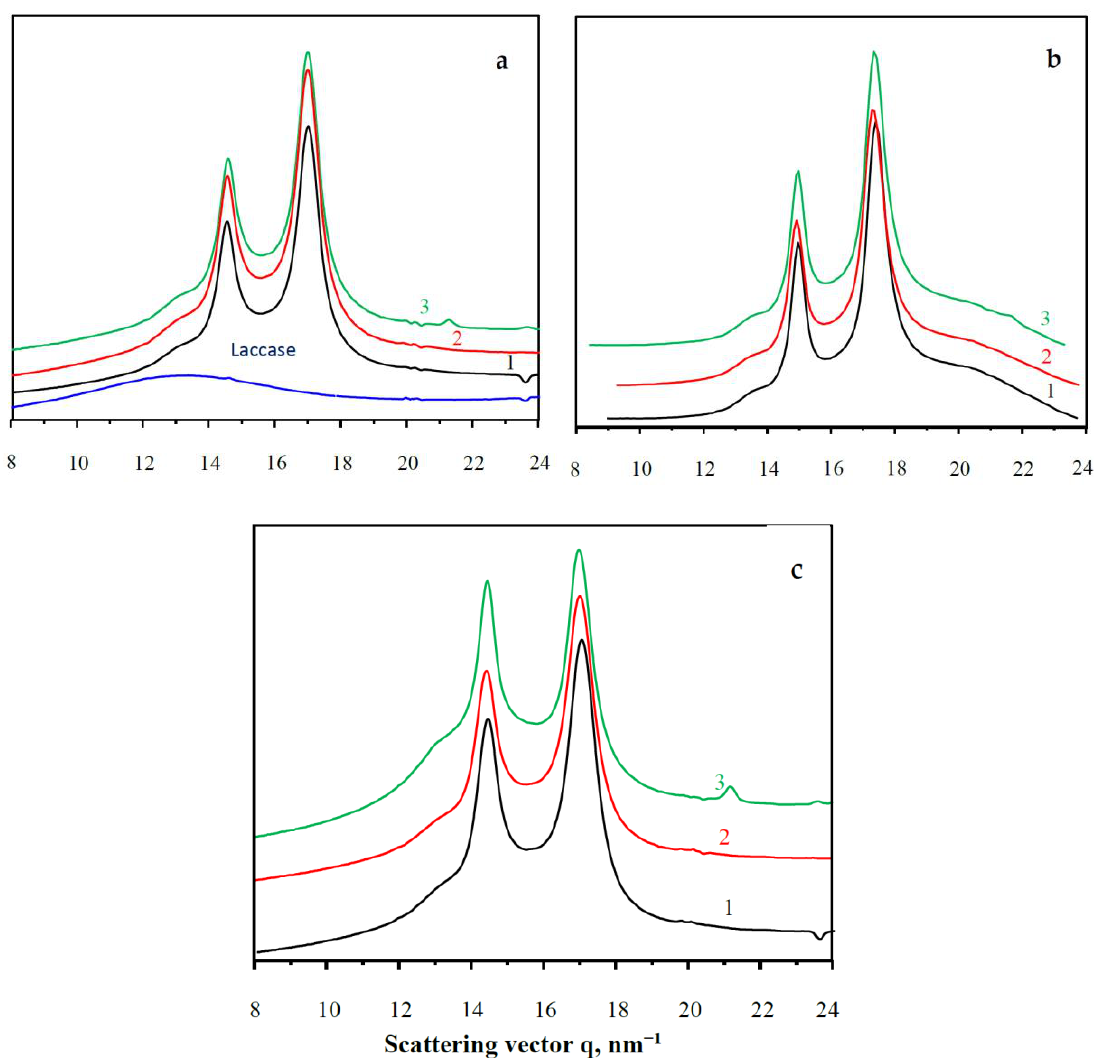
Figure 7. Background corrected linear WAXS patters of: ( a ) neat PA4 supports; ( b ) PA4@iL; ( c ) PA4@eL conjugates. 1—PA4; 2—PA4-Fe: 3—PA4 Fe 3 O 4 supports. The curves are shifted along the vertical axis for better visibility.